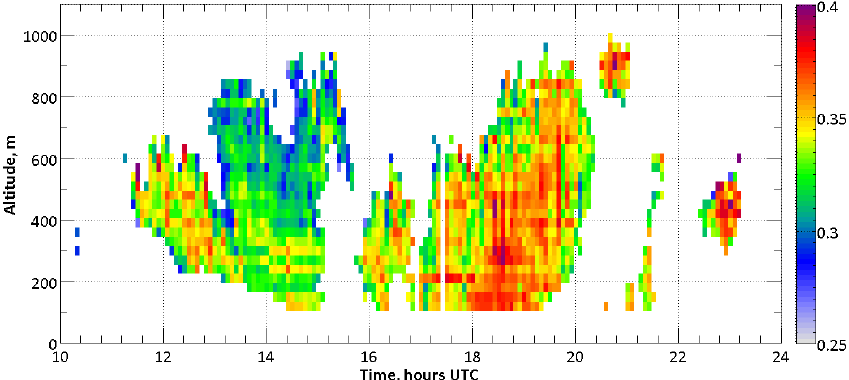
Fig. 11. Depolarization ratio profiles measured with the Doppler lidar at Utö on 22 May